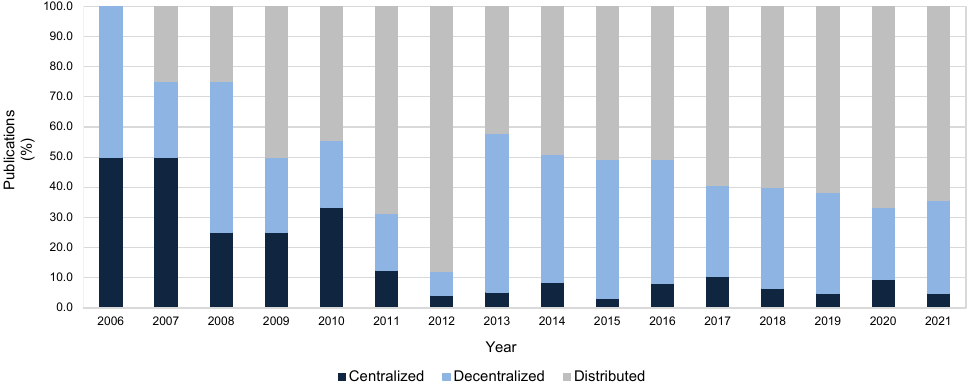
Figure 2. Sample of publications regarding control systems for microgrids annually categorised by the communication infrastructure of